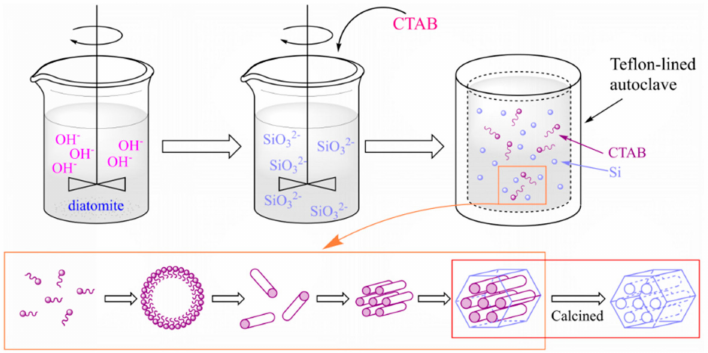
Figure 1. Schematic representation of MCM-41